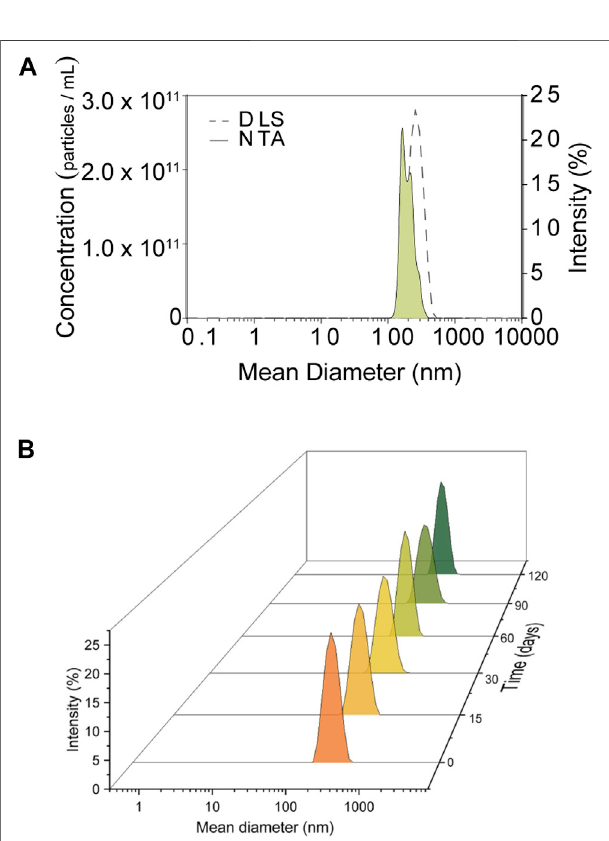
FIGURE 1 | Size distribution pro fi le and concentration of the NLCs over time (at 0, 15, 30, 60, 90, and 120 days), obtained by DLS and NTA, for the suspension of NLCs loaded with geraniol (GRL) and icaridin (ICA). The analyses were performed in triplicate (n (cid:2) 3).